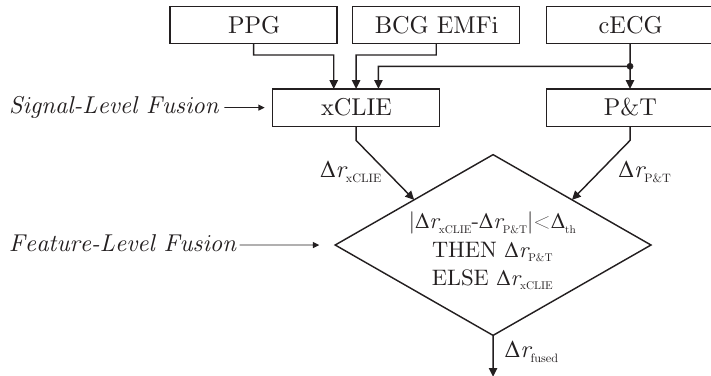
Figure 6. Combined signal and feature-level fusion approach to improve beat-to-beat interval